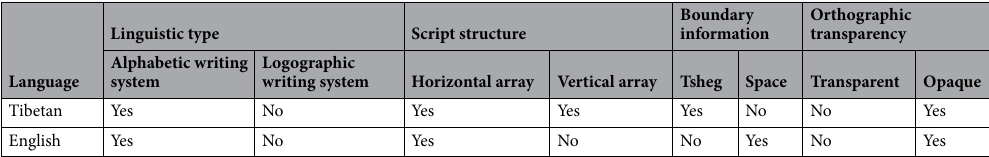
Table 1. Comparisons between Tibetan and English.